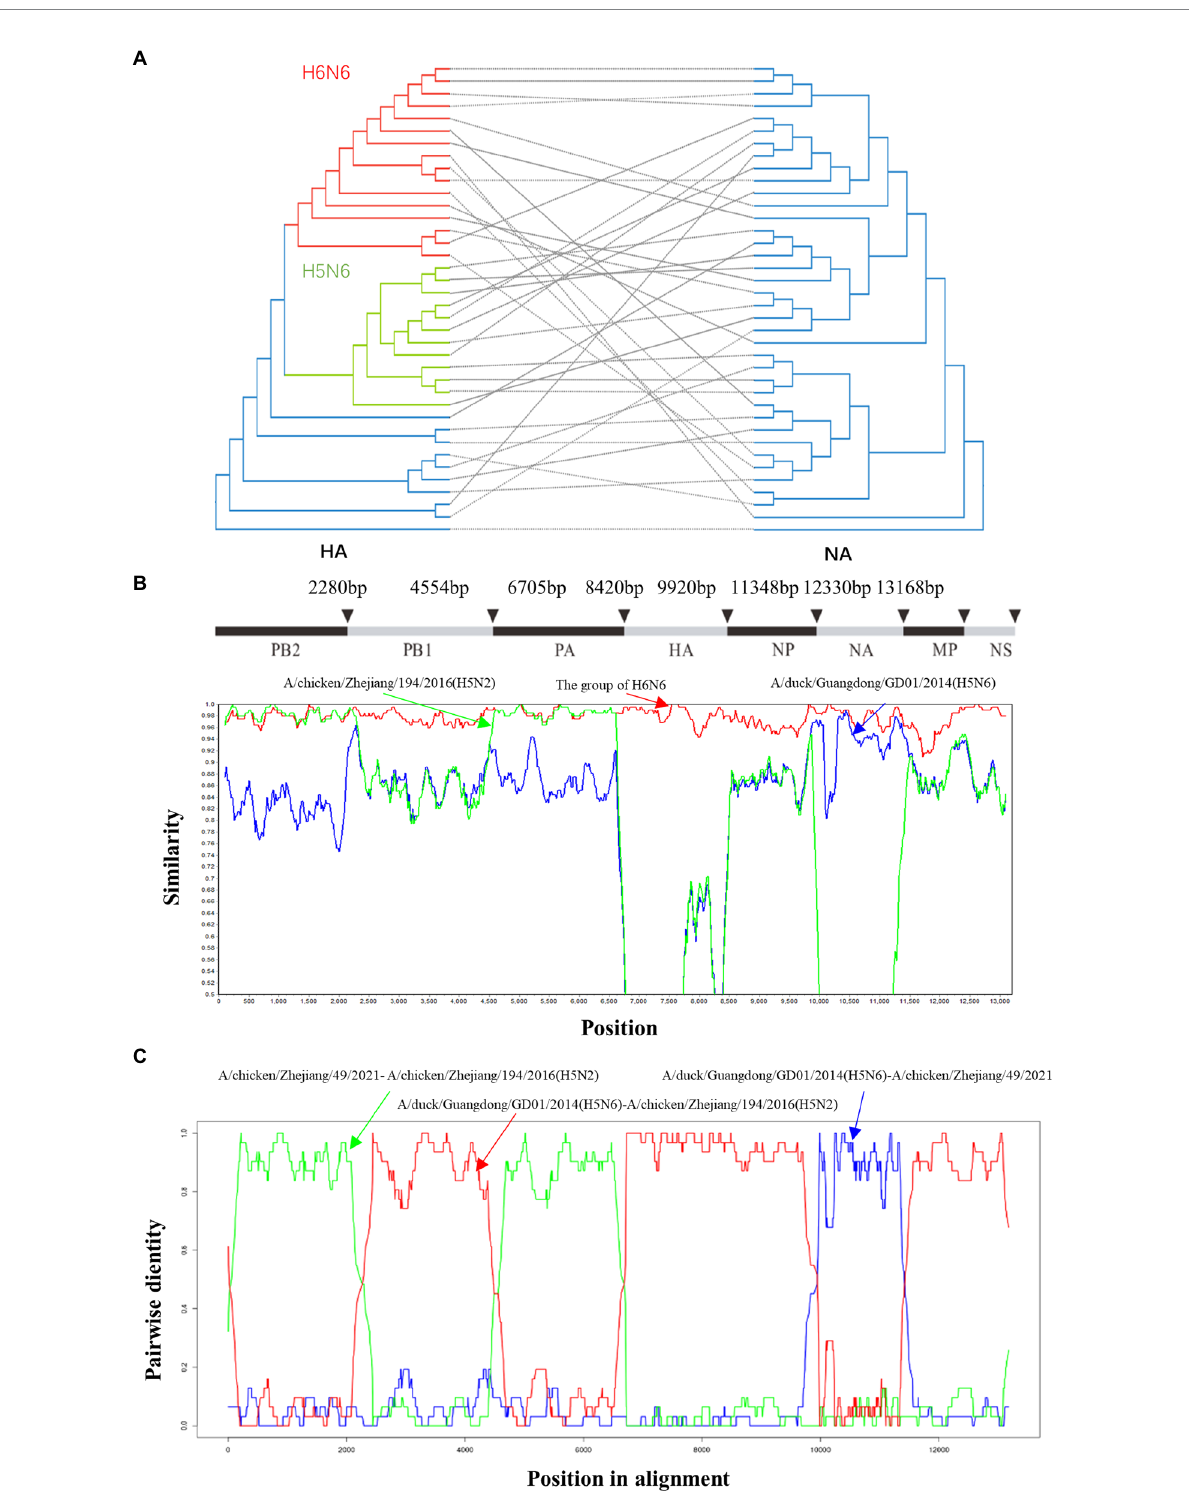
FIGURE 4 Reassortment analysis on concatenated H6N6 virus genomes. (A) ML phylogenetic trees inferred for HXN6-subtype AIVs HA and NA using RAxML under the general time-reversible substitution model with gamma-distributed rates across sites. In total, 1,000 bootstraps were evaluated to assess support values. (B) Reassortment analysis was performed using Simplot (v.3.5.1). The H6N6 group mainly included the following strains: A/duck/ Jiangxi/10.30_NCNP67B3-OC/2017 (H6N6), A/duck/Ganzhou/GZ151/2016 (H6N6), A/chicken/Hunan/1.12_YYGK22H3-OC/2018 (H6N6),